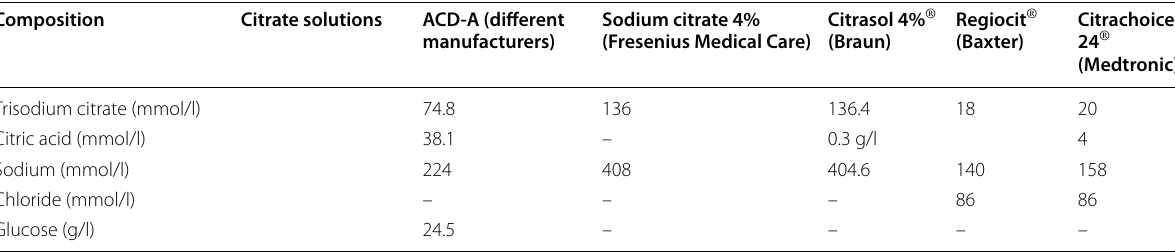
RRT renal replacement therapies availability and trade name of each solution may vary according to different countries